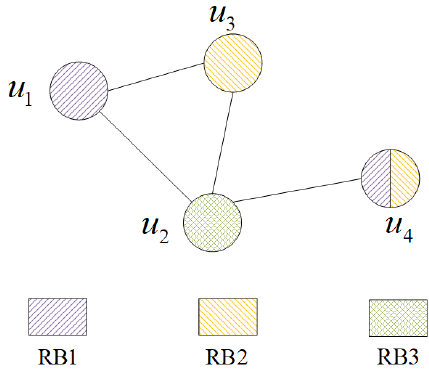
Figure 3. Dynamic Spectrum